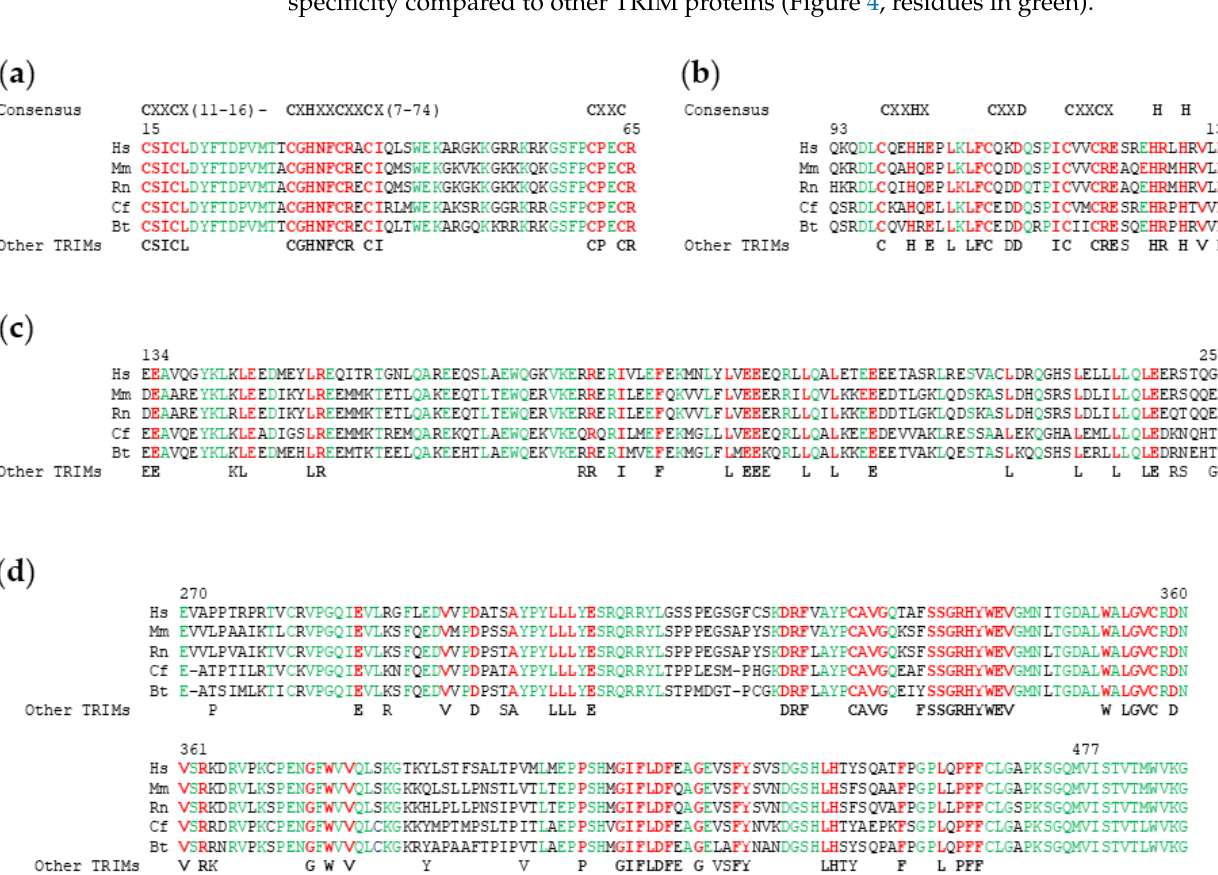
Figure 4. Species conservation of TRIM17 RING ( a ), Bbox2 ( b ), coiled-coil ( c ) and PRY-SPRY ( d ) domain sequences and comparison with other TRIMs and known consensus sequences. In bold, TRIM17 conserved residues in consensus sequence or shared by other TRIMs. In red, conserved residues through species. In green, residues highly conserved through species possibly involved in specificity of TRIM17.